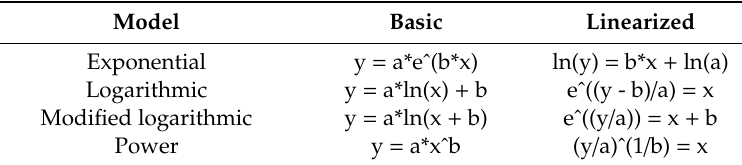
Table 2. Dependence models of increased volume, expansion and deepening of the borehole on the amount of explosive charge.